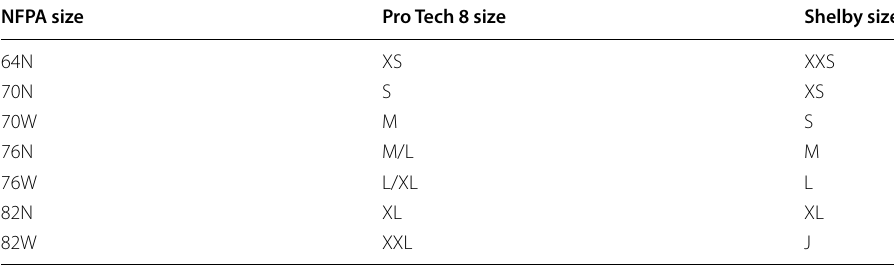
From NFPA (2018a), Pro-Tech 8 (2018), Shelby,